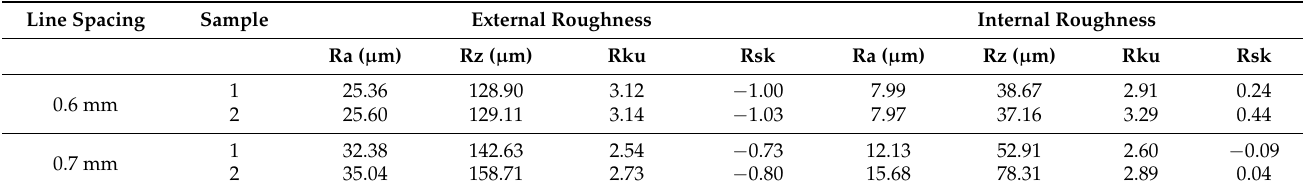
Table 2. Roughness on the external and internal layer of 3D printed steel-filled samples.